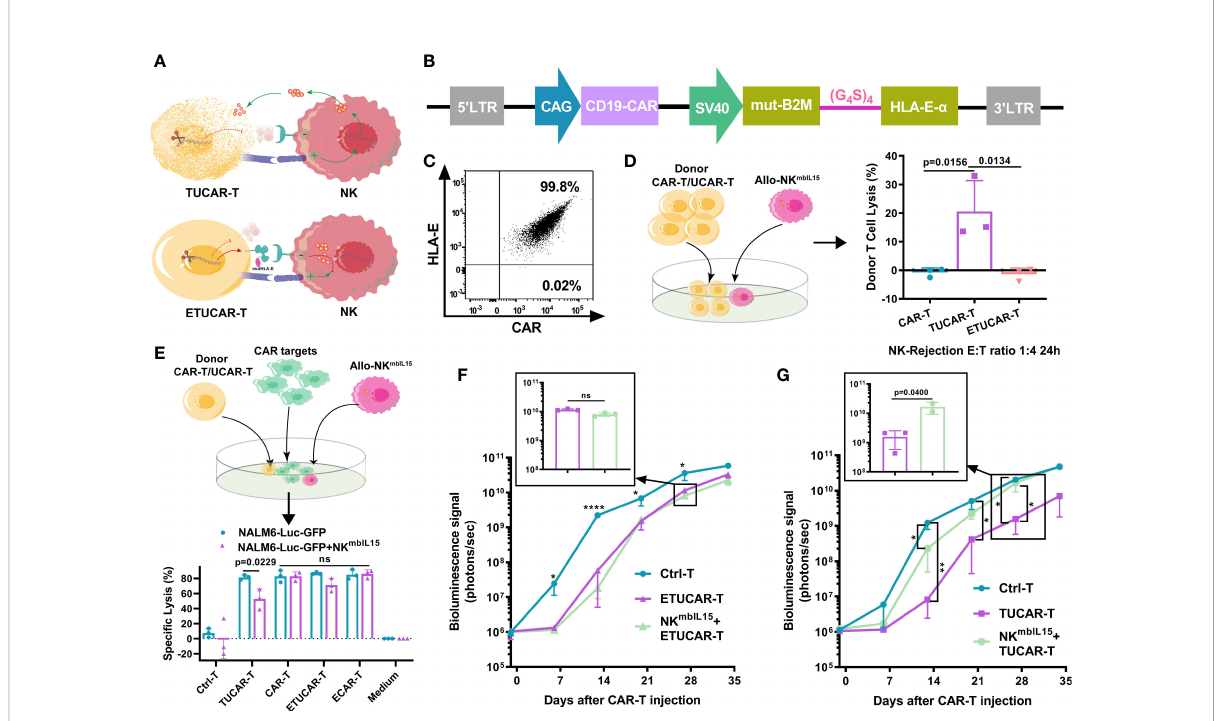
FIGURE 3 The HLA-E helps UCAR-T cells to escape the lysis induced by NK cells in vivo (A) , Schematic representation of HLA-I de fi cient TUCAR-T cells attacked by NK cells. (B) , Schematic design of the ECAR constructs. (C) , The representative data of HLA-E and CAR coexpressed on T cells by FCM. (D) (Left) Schematic of the model setup for UCAR-T cells rejected by NK mbIL15 . (Right) TUCAR-T cells were lysed by NK mbIL15 ; NK mbIL15 and donor UCAR-T cells were mixed at a 1:4 ratio for 24 h (n = 3 ). (E) (Top) Schematic diagram of the simulated cell killing in vivo with Allo- NK mbIL15 . (Bottom) Cytotoxicity of ETUCAR-T and TUCAR-T cells was assessed by measuring the percentages of tumor cell lysis using the luciferase assay (n = 3). The tumor cell lysis ratio is 1:4 by the effective cell count; the allo-rejection cell lysis ratio is 1:1 by the total cell count. (F, G) BLI from each group of mice (n = 3). All data represent the mean ± SD. Statistical signi fi cance was determined with two-tailed, unpaired Student ’ s t -test (E) or one-way ANOVA with Tukey ’ s correction for multiple comparisons (D, F, G) . Signi fi cances of p ≤ 0.05 are indicated by 1 asterisk (*), p ≤ 0.01 are indicated by 2 asterisks (**), p ≤ 0.0001 are indicated by 4 asterisks (****). Signi fi cance of p>0.05 are indicated by nonsigni fi cant